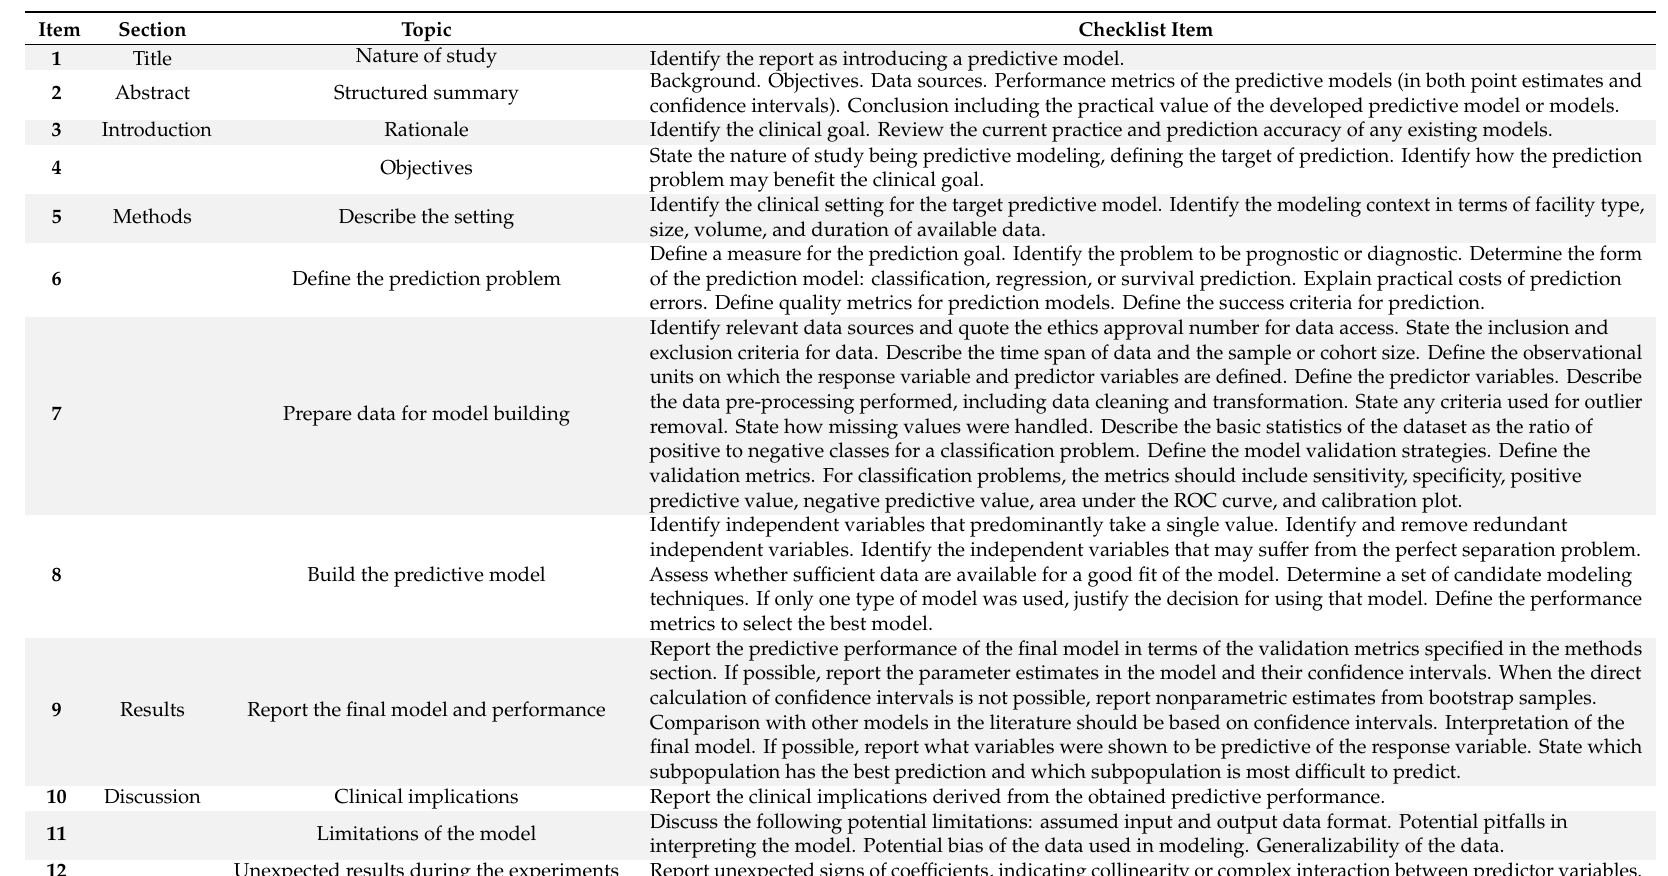
Table 1. Items to include when reporting predictive models in biomedical research. Luo et al., 2016